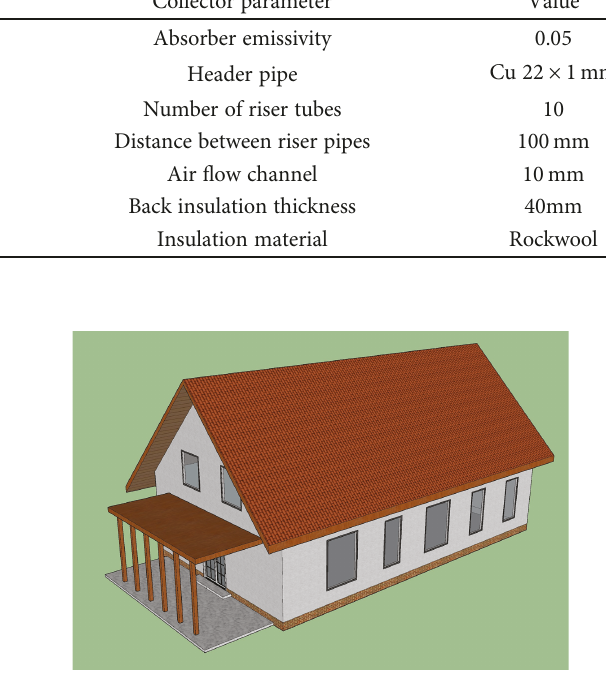
Figure 8: Three-dimensional geometry of the considered